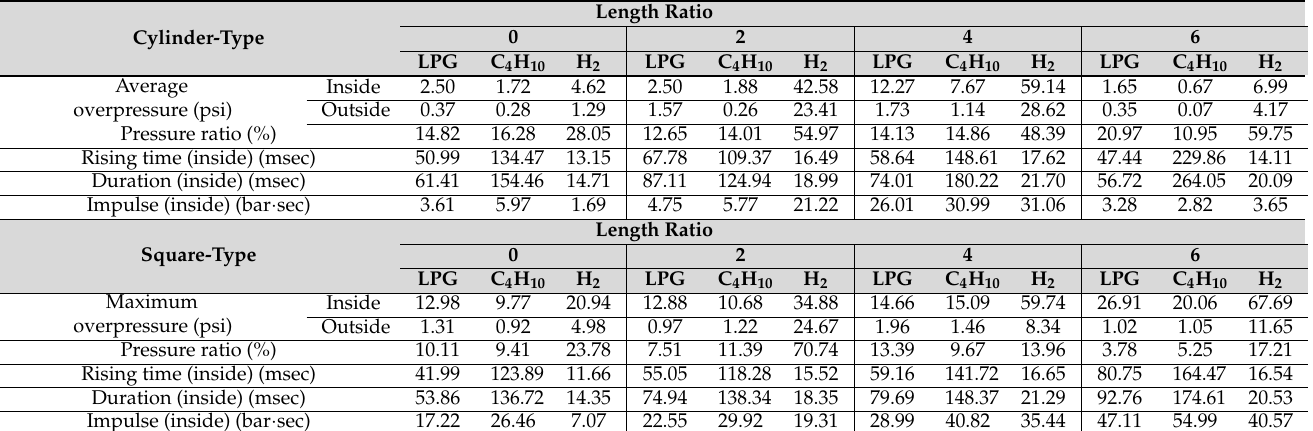
Figure 22. Average impulse in the square-type chamber. Table 5 summarizes the average values of the maximum overpressure, rising time, duration, and impulse for all experiments performed in this study. Table 5. Summary of explosion characteristics obtained experimentally (LPG (propane 98%); C 4 H 10 : butane; H 2 : hydrogen).